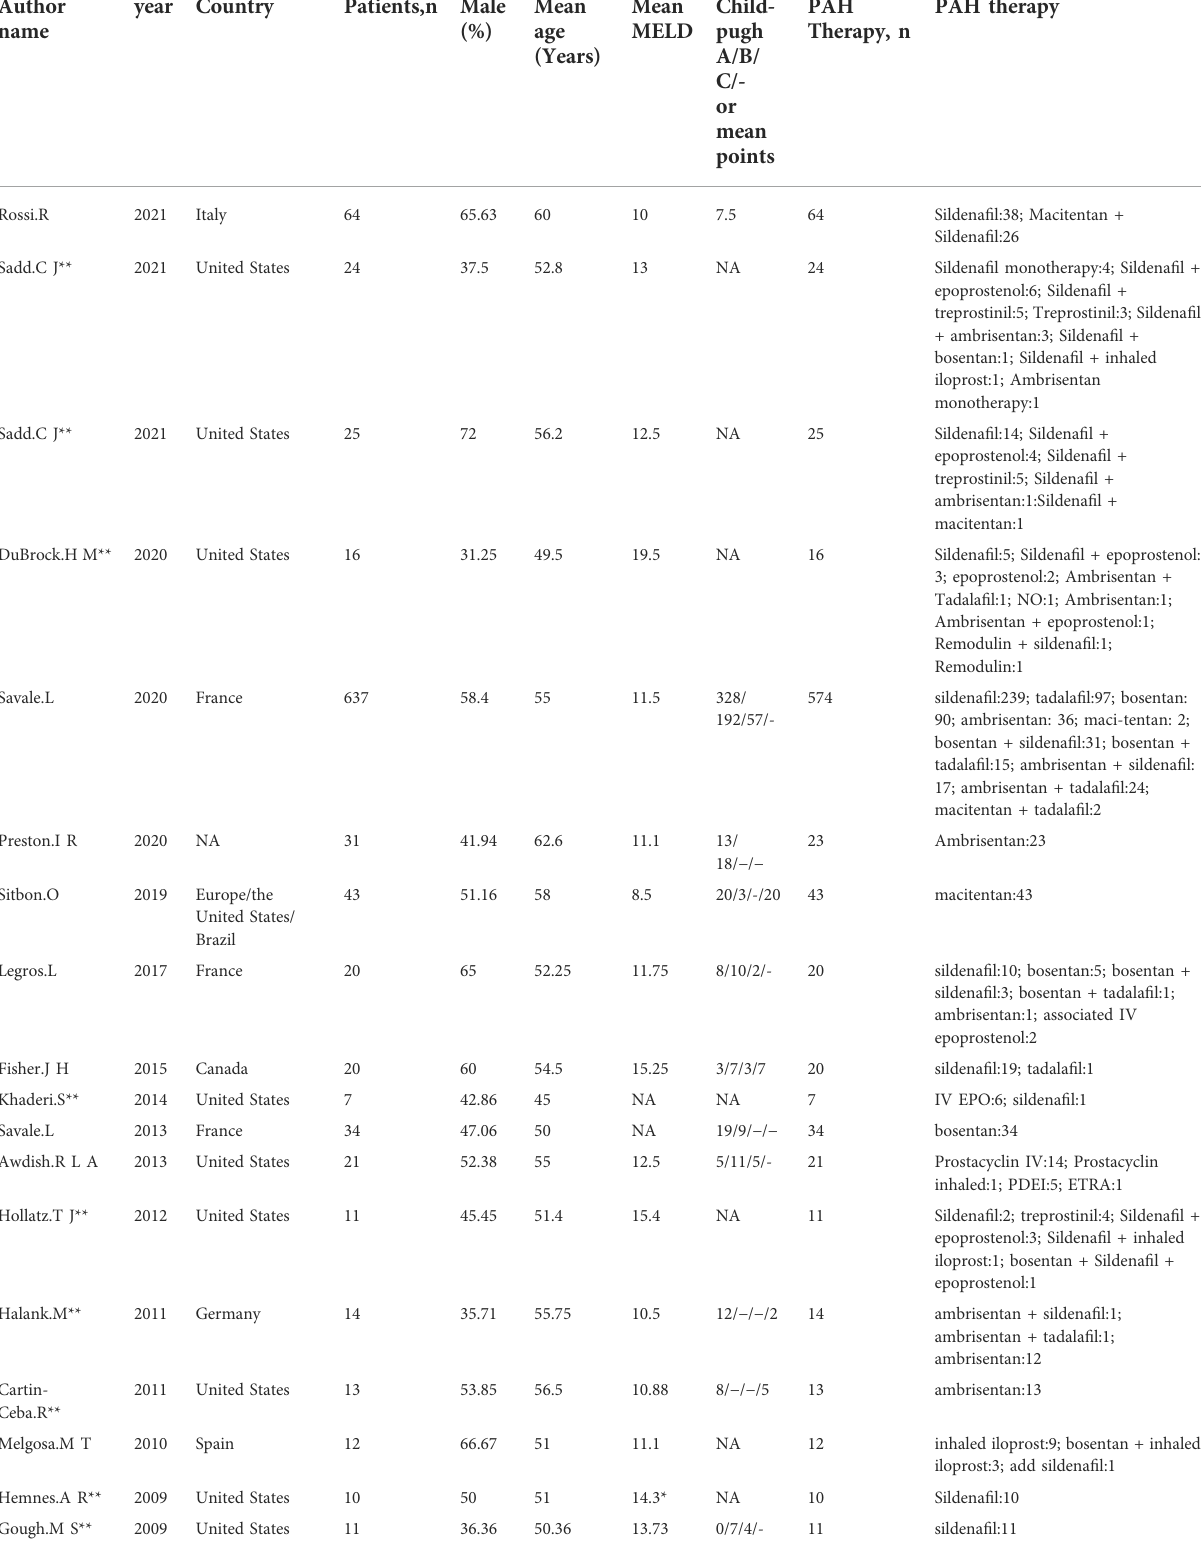
TABLE 1 Characteristics of the 27 included